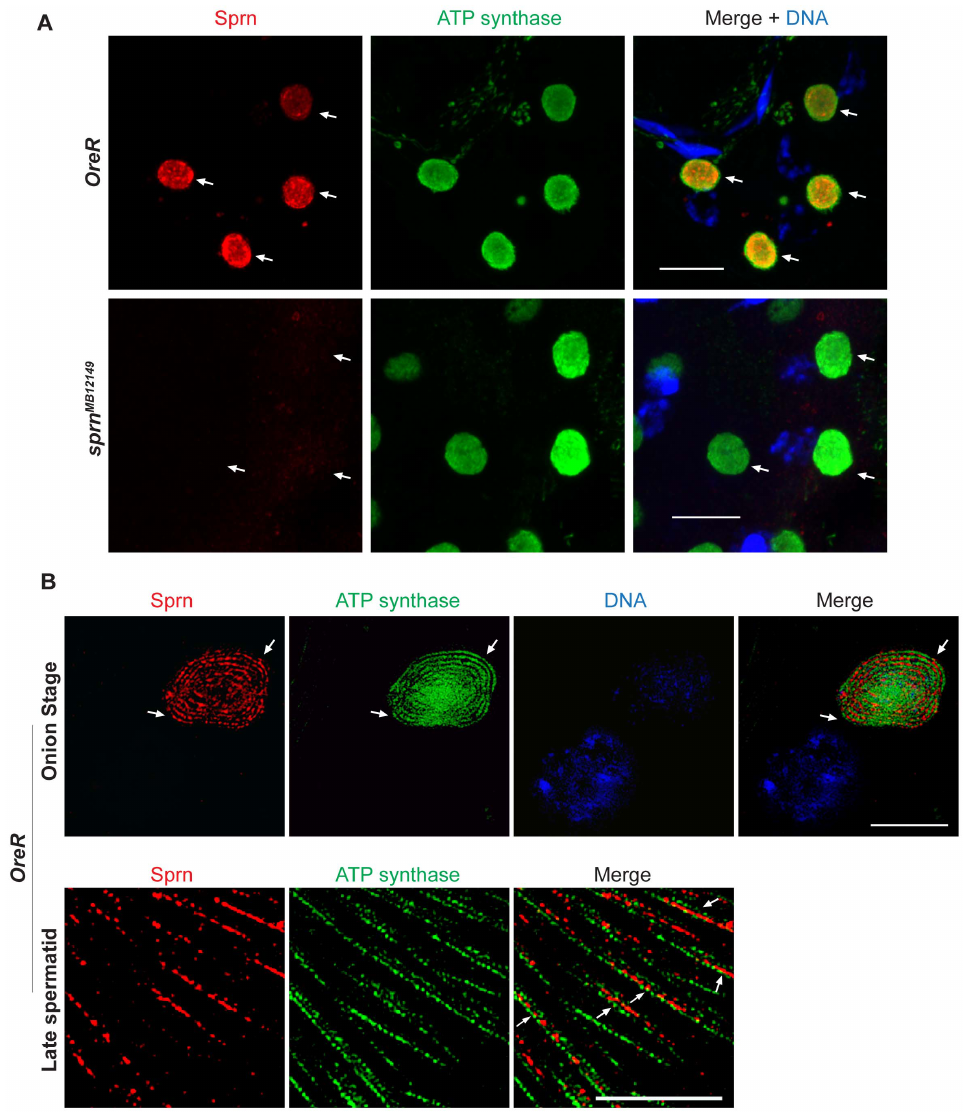
Figure 3. Sprn localizes in the nebenkern lumen. (A) Sprn is absent from sprn MB12149 mutant nebenkerns (arrows). Scale bars, 10 m m. (B) Superresolution images showing Sprn localizes in the matrix of the nebenkern in spermatids. In the onion stage (upper panel), when two big mitochondrial derivatives wrap around one another to form the nebenkern, Sprn does not overlap with the mitochondrial inner membrane marker ATP synthase complex V subunit alpha (arrows). And in late spermatids (lower panel), when the mitochondrial derivative becomes a slender and cylindrical tube, Sprn is in the matrix of mitochondria, as shown localizing in-between the inner membranes marked by ATP synthase complex V subunit alpha in the longitudinal section (arrows). Scale bars, 5 m